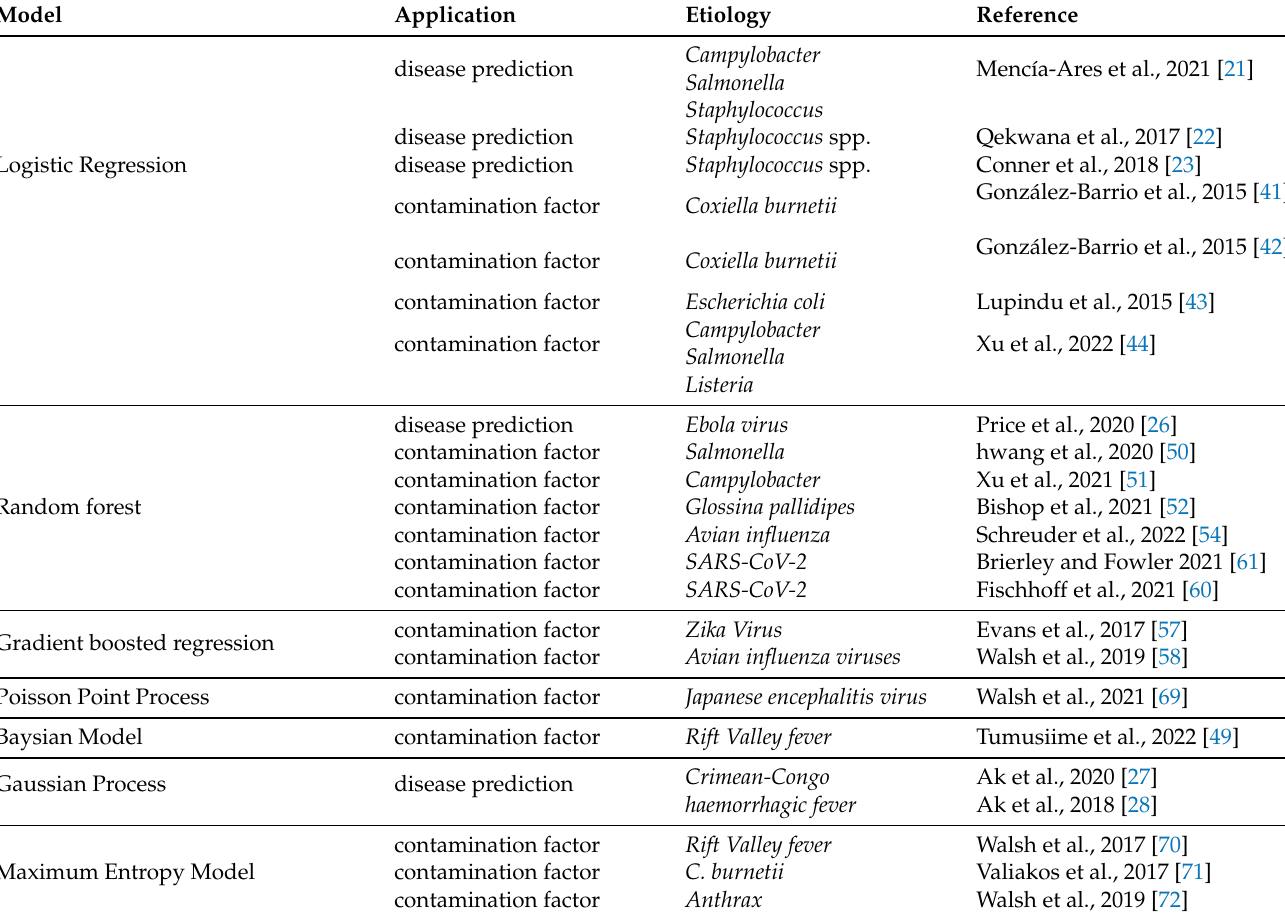
Table 1. Summary of AI models and their applications in zoonoses